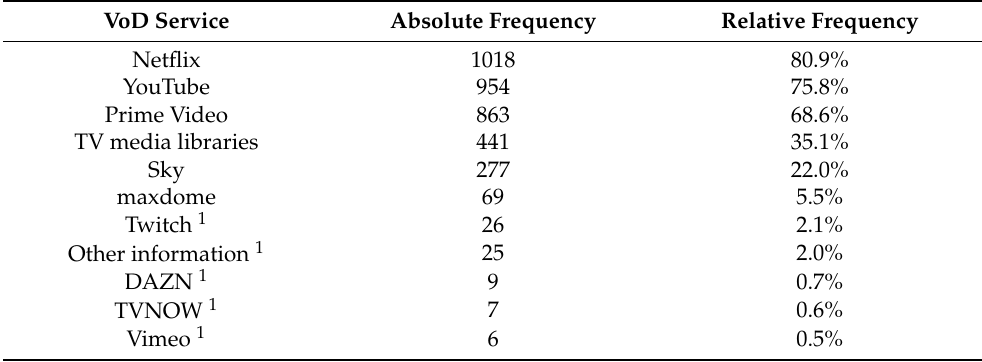
Table 1. Frequencies of use of VoD services (multiple answers, additional answers from the free text field). Question: Which video streaming services do you use? (N = 1258). VoD Service Absolute Frequency Relative